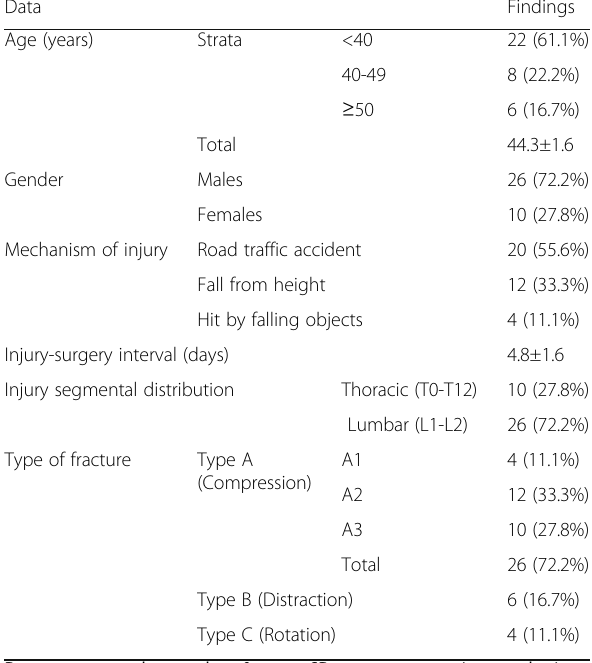
Table 3 Operative and postoperative data of studied patients